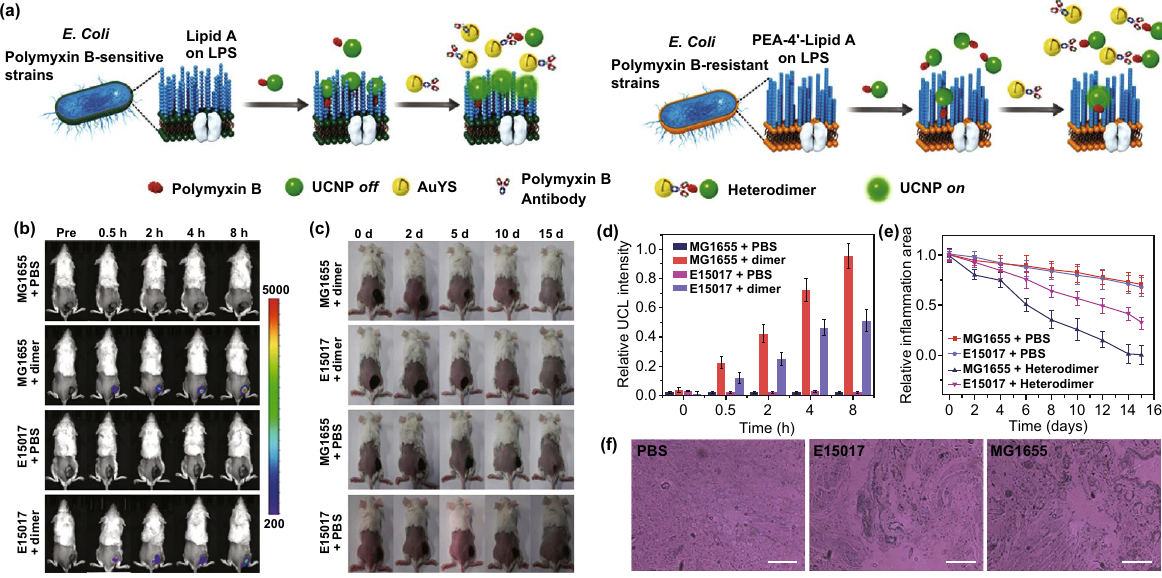
Fig. 8 a Schematic illustration of Au YS and UCNP heterodimer for quantitative detection and imaging of drug-resistant bacteria. b Time- dependent in vivo UCL imaging before and after i.v. injection of Au YS-UCNP heterodimer into inoculation of polymyxin-B-sensitive strains (MG1655), polymyxin-B-resistant bacteria (E15017), and PBS control. c Representative photographs of mice for MG1655 or E15017 infection- bearing mice with Au YS-UCNP heterodimer or PBS treatment upon 532 nm irradiation. d Average UCL signals in the infected region at dif- ferent time points in each group. e Relative inflammation area after heterodimer or PBS treatments for 15 days. f Hematoxylin and eosin (H&E) images of non-infected and infected sites. Scale bar: 100 μm [92]. Copyright 2018